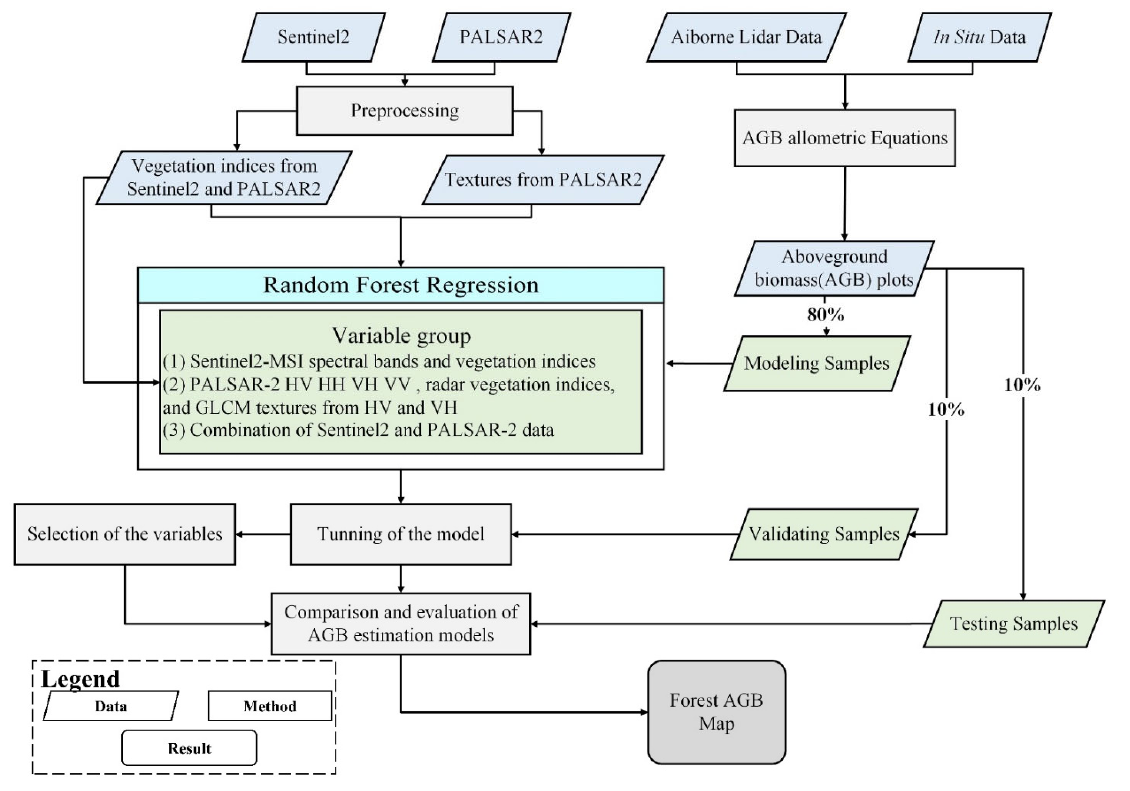
Figure 2. Research flow for calculating aboveground biomass (AGB). Abbreviations: GLCM, gray- level co-occurrence matrix; HH, horizontal transmit–horizontal channel; HV, horizontal transmit–vertical channel; MSI, multispectral instrument; VH, vertical transmit–horizontal channel; VV, vertical transmit–vertical channel.